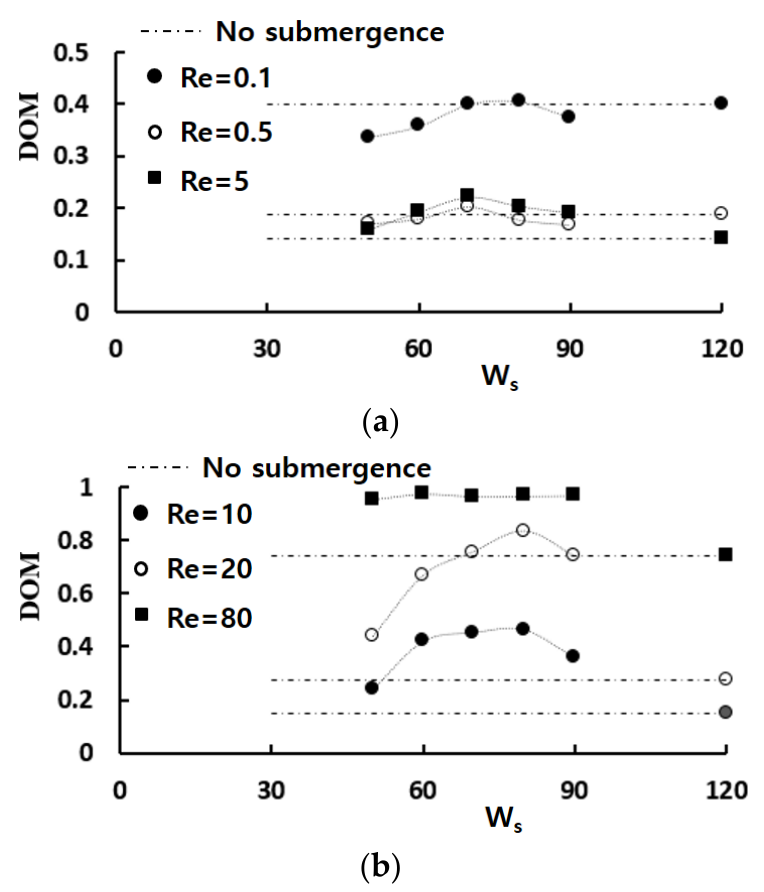
Figure 7. Effects of the height of submerged structure on the DOM: ( a ) Molecular dominance and transition regime of mixing and ( b ) Convection dominance regime of mixing.